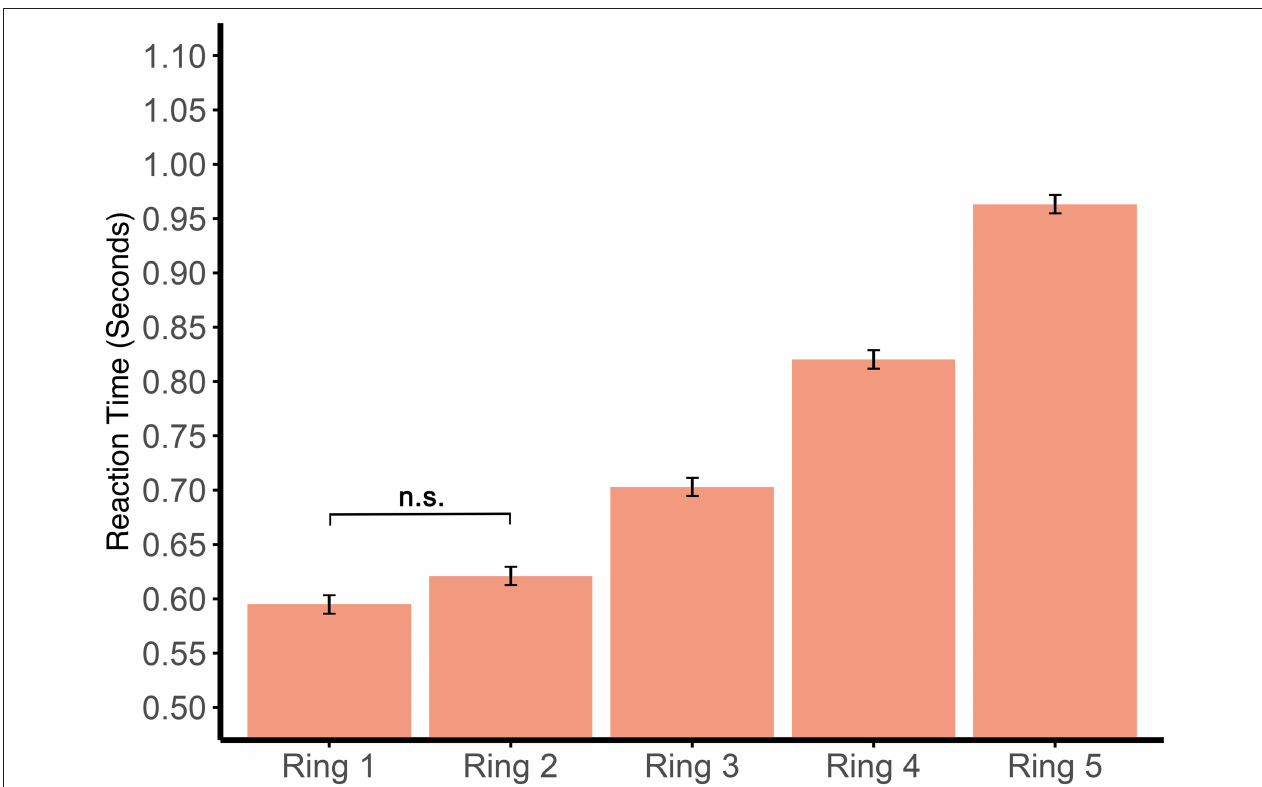
FIGURE 2 | Average reaction times by location. The figure demonstrates the average reaction times for all participants in the five rings of the Dynavision board across all three proactive tasks. Ring 1 is the innermost ring of the board, with each ring progressing outward toward the outermost ring, Ring 5. All pairwise comparisons indicated significant differences except between Ring 1 and Ring 2, which is denoted by n.s